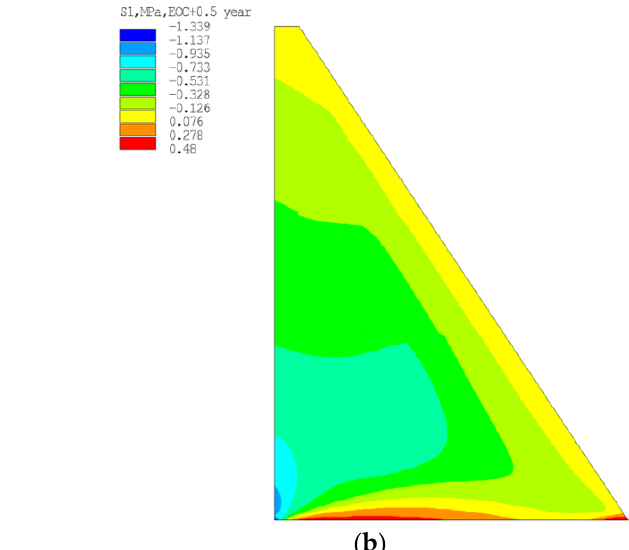
Figure 15. Results of calculation of plastic deformation in concrete mass at the time of completion of construction with: ( a ) The most favorable design case; ( b ) The least favorable calculation case.